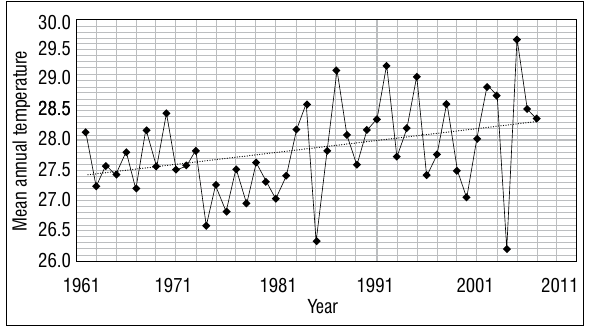
Figure 4: Community awareness of local climate change in the Makonde Rural District ( n =434).